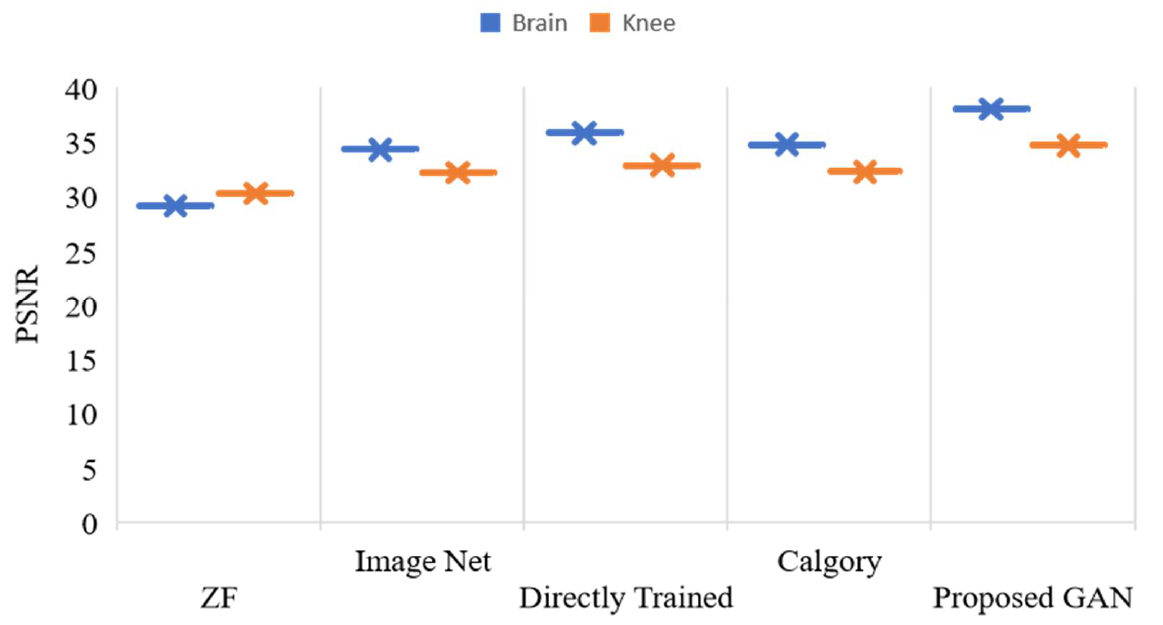
Figure 11. PSNR, values of reconstructed images of the knee and brain using various models, with AF = 2.